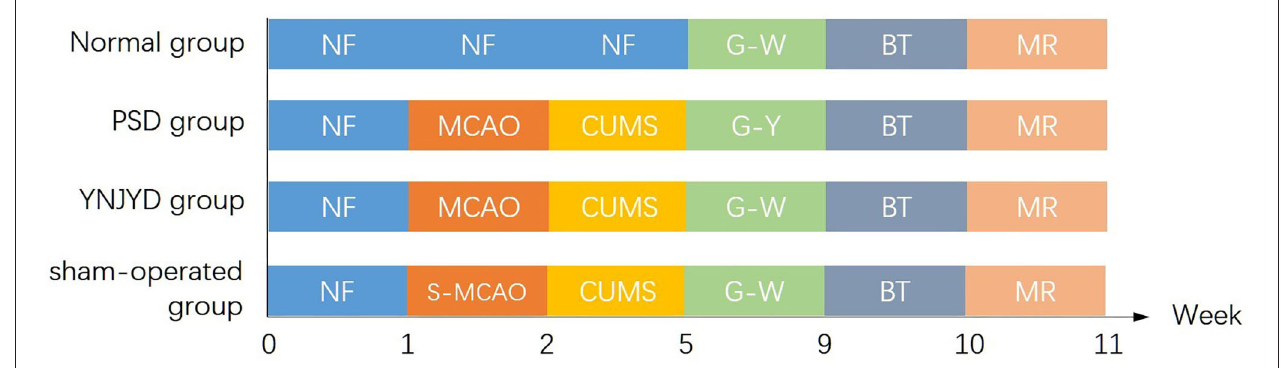
FIGURE 1 | Experimental timeline of the four groups, including a normal group, a post-stroke depression (PSD) group, a yi-nao-jie-yu decoction (YNJYD)-treated group, and a sham-operated group, who underwent normal feeding (NF), middle cerebral artery occlusion operation (MCAO), sham operation for middle cerebral